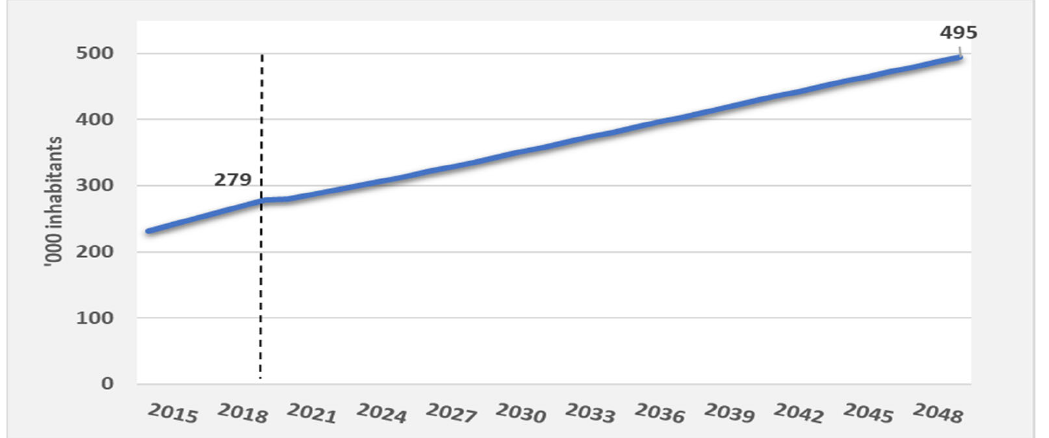
Figure 6. Population projections in thousand inhabitants [22].